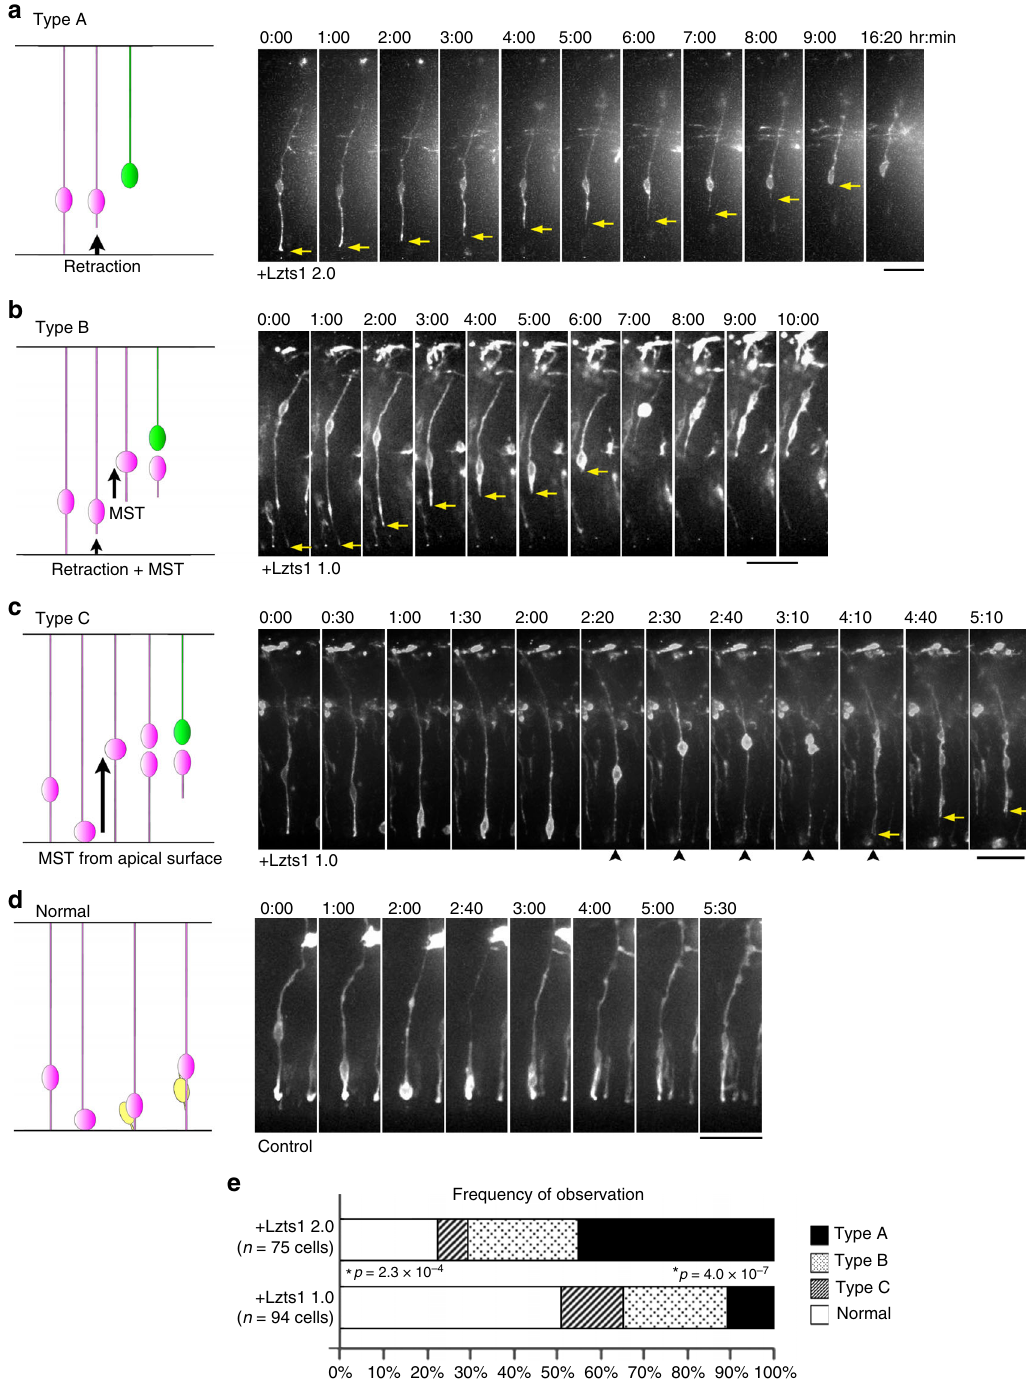
Fig. 6 Lzts1 overexpression induces delamination and MST. Time-lapse images of Lzts1-overexpressing aRG-like cells (pCAG::Lzts1: 2.0 μ g μ l − 1 in a , 1.0 μ g μ l − 1 in b and c or control EGFP-expressing cells d . The endfeet of the apical processes are indicated by arrows. Electroporation was performed at E12, and 8 – 24 h later, brain slices were cultured and images of aRG-like cells were captured for 20 h. See also Supplementary Movies 1 – 4. a Image of an lzts1 - overexpressing cell showing the retraction of its apical process without mitosis (Type A). b Image of an lzts1 -overexpressing cell that retracted its apical process from the apical surface, presumably during G2 phase, and underwent MST after retraction (Type B). c Time-lapse images of an lzts1 - overexpressing cell showing the “ MST from the apical surface ” behavior after apical INM during G2 phase (Type C). Note that the apical process was maintained during mitosis (arrowheads). d Time-lapse images of the aRG-like cell in the control experiment showing normal INM and apical division. In control experiments, all aRG-like cells that we observed (63 cells from fi ve embryos) exhibited this pattern. e The lzts1 plasmid concentration in the electroporation was related to the type of behaviors exhibited by aRG-like cells ( N = 75 and 94 cells from six and four embryos). Type A was predominantly observed in cells electroporated with 2.0 μ g μ l − 1 pCAG::Lzts1 (see also Supplementary Figure 7) (Fisher ’ s exact test, two-sided, with Bonferroni-adjusted P value p < 0.05/4 = 0.0125). Bars, 50 μ m in a –